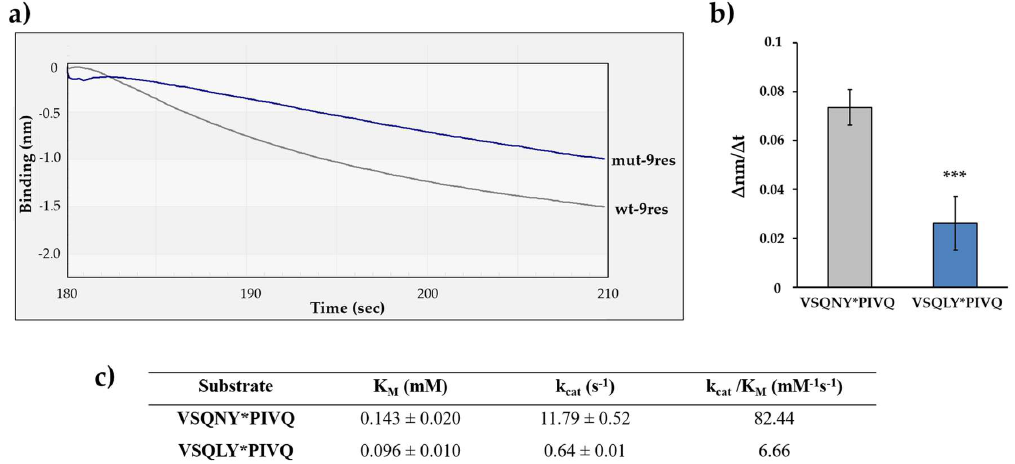
Figure 6. Determination of substrate specificity of HIV-1 PR using P2-modified RFP substrates. ( a ) Representative sensogram of the enzyme reactions with different substrates wt-9res (VSQNY*PIVQ) mut-9res (VSQLY*PIVQ). ( b ) Comparison of obtained ∆ nm/ ∆ t values. The initial ∆ nm/ ∆ t values were determined based on the slopes (2–10 s after initiation of the reaction). ***: p = 0.0004. Error bars represent SD (n = 4). ( c ) Kinetic parameters determined previously for HIV-1 PR using oligopeptide substrates representing 9-residue-long cleavage sites [44]. Representative signal curves are shown for all steps of the assay in Figure